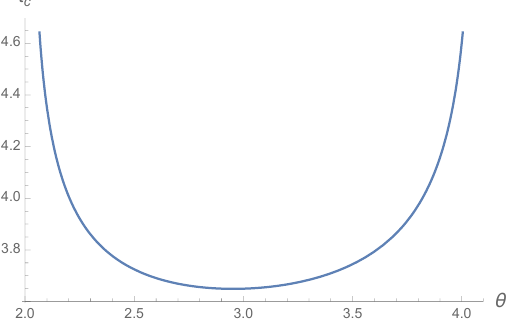
Figure 9. Plot of t c against θ for r = 0 . 1 , λ = 0 . 001 , c 1 = 0 . 1 , c 2 = 0 : the critical temperature increases sharply near the edges of the interval ( θ